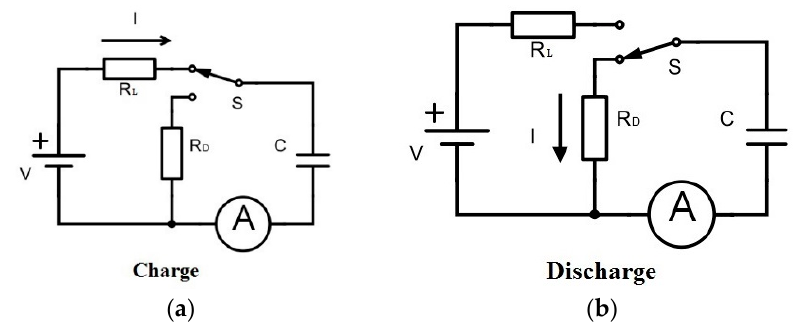
Figure 4. Schematic view of the RC charge–discharge circuit. In the charge configuration, ( a ) the capacitor ( C ) is powered by the power supply ( V ) through the load resistance ( R L = 2 M Ω ). In the discharge configuration, ( b ) the discharge resistance ( R D ) is powered by the capacitor. Note that the current ( I ) flows in different directions through the ammeter ( A ) depending on whether the configuration is charge or discharge.